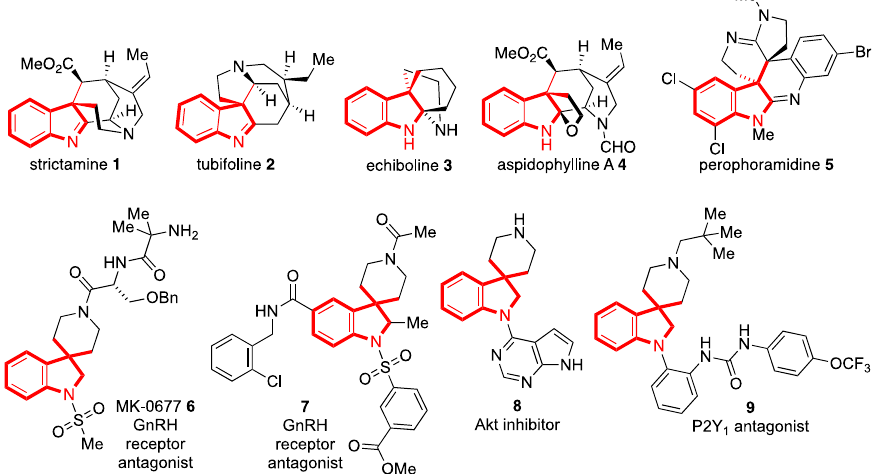
Figure 1. Natural products containing the 3,3-dialkyl indolenine motif and related spiroindoline structures.